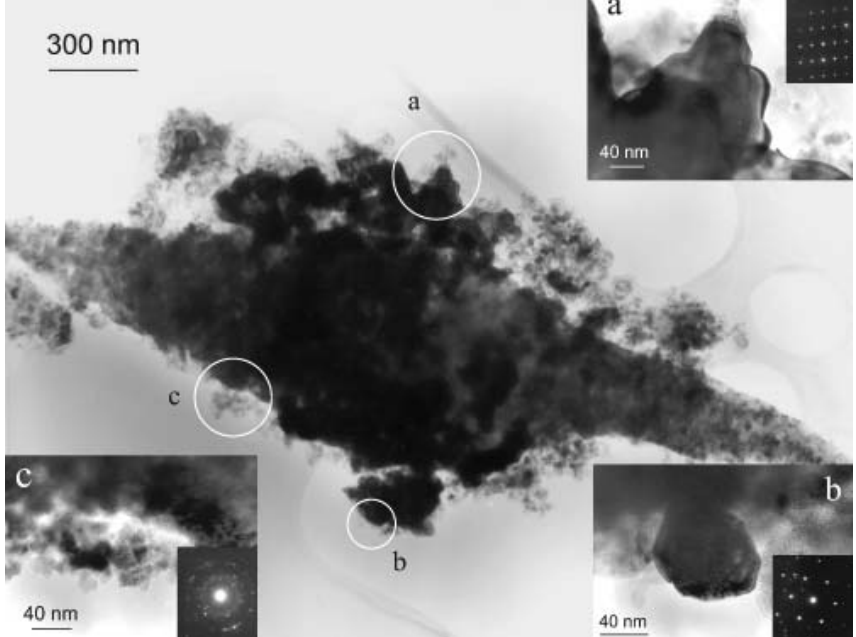
Fig. 2 Bright-field TEM image of a CZA sample calcined at 1100 K. Insets display local expanded views and their corresponding ED patterns: a) α -Al axis) and c) θ -Al